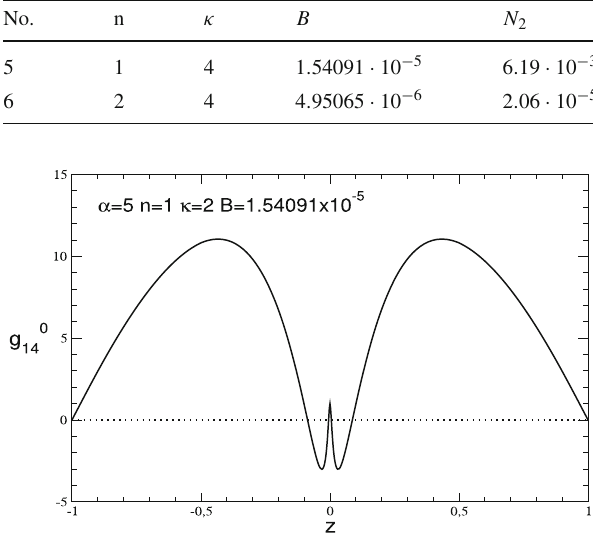
Fig. 8 g 0 from state No. 5 in Table 14